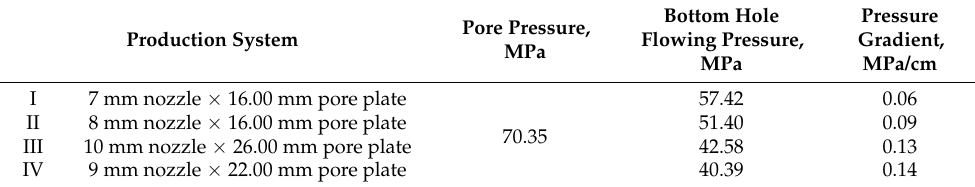
Table 2. Corresponding flowback pressure gradient under four production